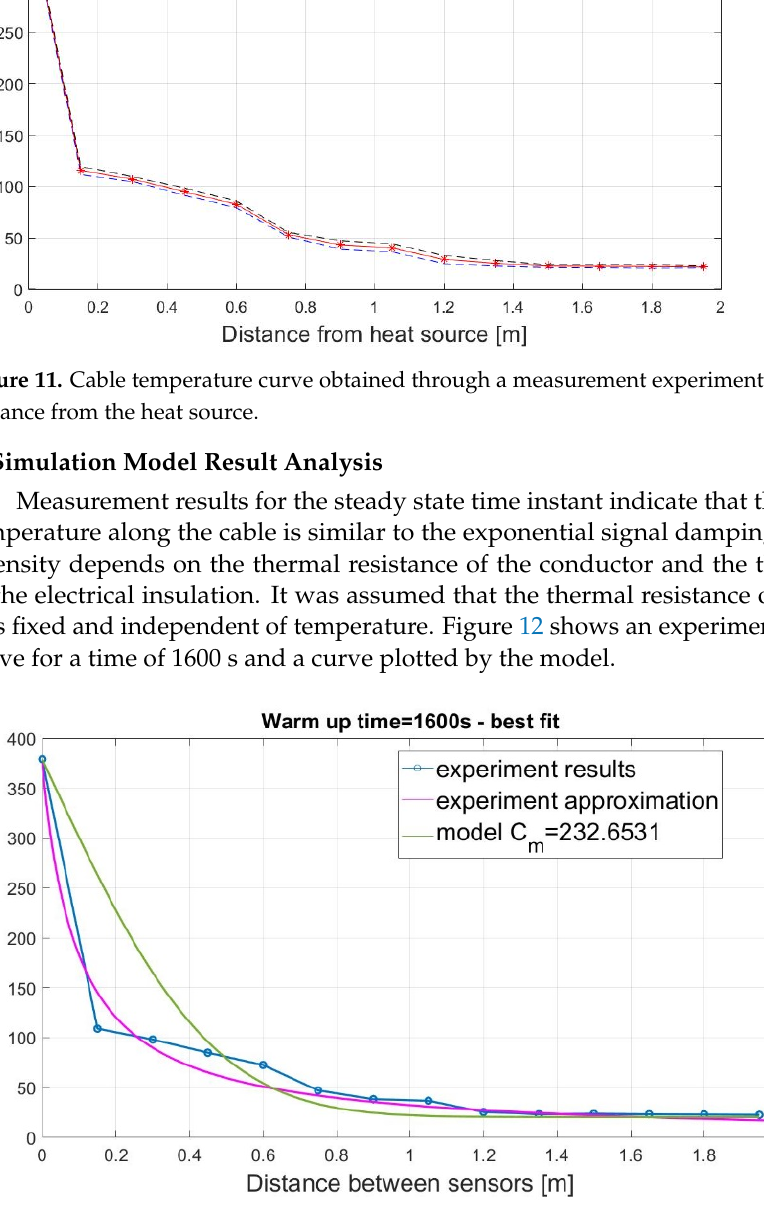
Figure 12. Plotted temperature curve best matching the experiment.